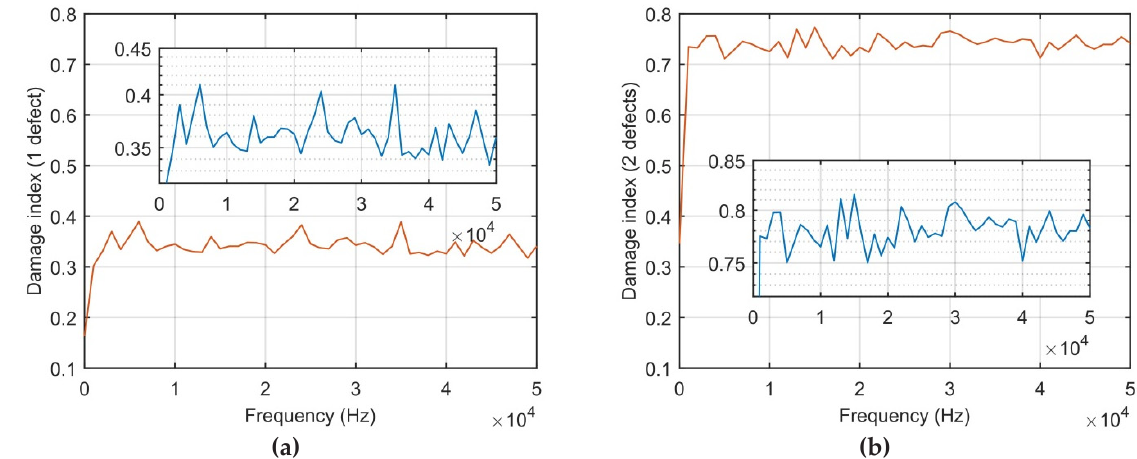
17 of 20 Figure 11. Impact force time responses: ( a ) Without defect; ( b ) One defect; ( c ) Two defects. (a) (b) Figure 12. Frequency response functions (FRFs): ( a ) One defect; ( b ) Two defects. The FRFs’ responses given in Figure 12 are obtained from the time-domain responses’